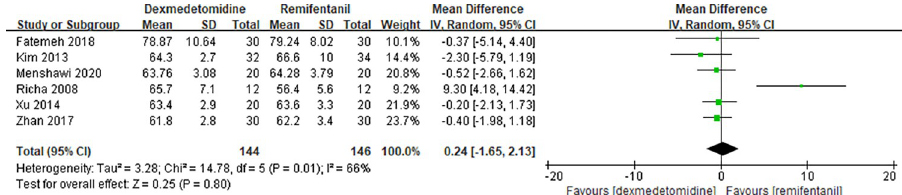
Fig 4. Forest plot of effects on MAP. Dexmedetomidine group vs. remifentanil group.